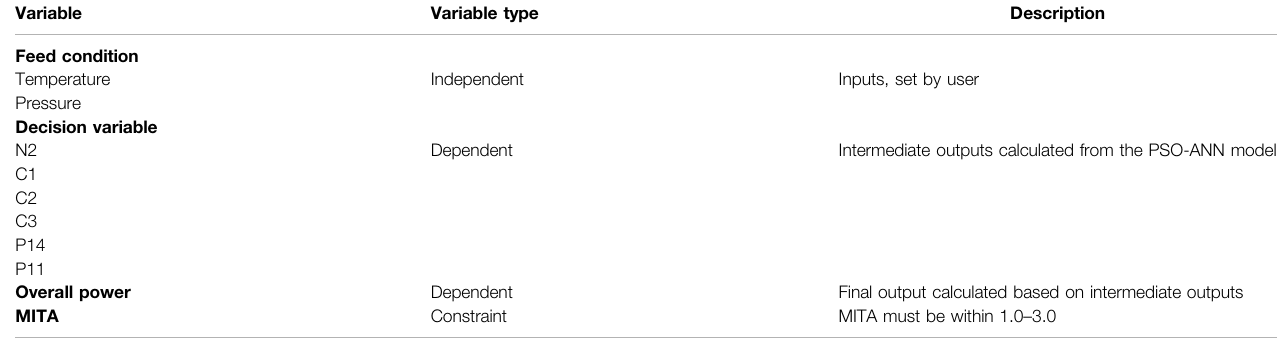
TABLE 5 | Summary of SMR-LNG process variables.